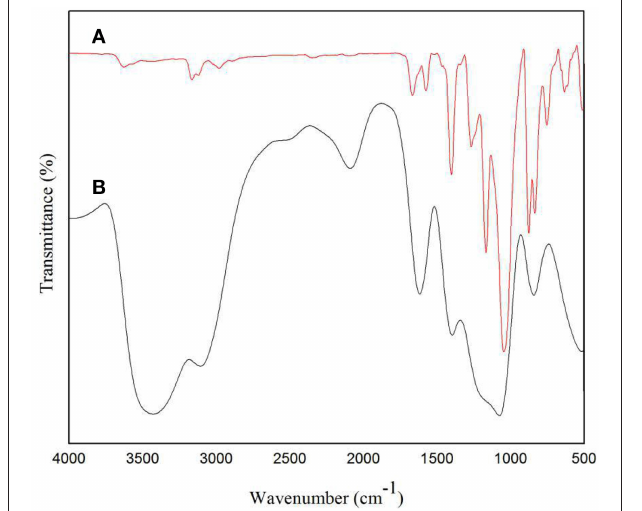
FIGURE 8 | CVs of PVDF/IL/MWCNTS SPEs with different MWCNT contents.